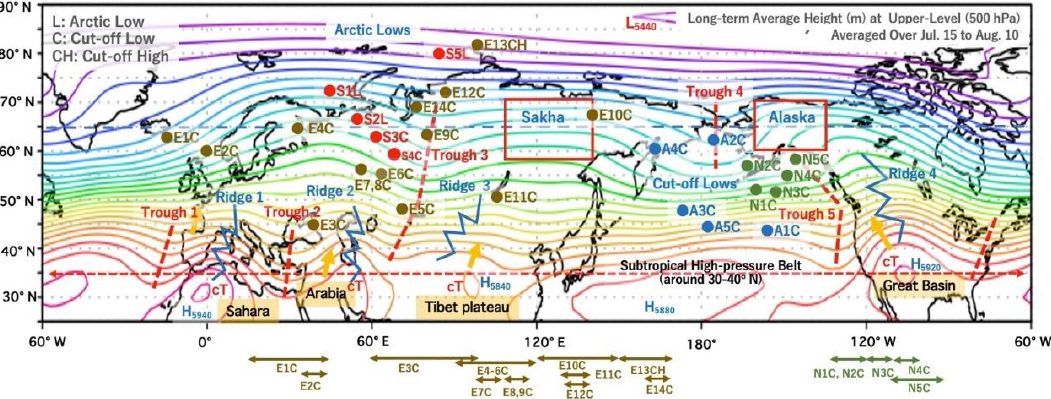
Figure 6. Map of part of the northern hemisphere (25° – 90° N, −6 0° – 360° E). Full names of E1C-E14C and S1L-S5L are in Table 1. Full names of N1C-N5C and A1C-A5C are in Table 2. Two rectangles with red lines are the regions of Sakha and Alaska. Red dotted lines show major troughs. Blue zigzag dotted lines show major ridges. Straight lines with arrows at both ends at the bottom of the figure show longitude locations of the other 19 areas (E1C-E14C and N1C-N5C). Base map is the upper air (500 hPa) weather map (long-term average map for 74 years from 1948).